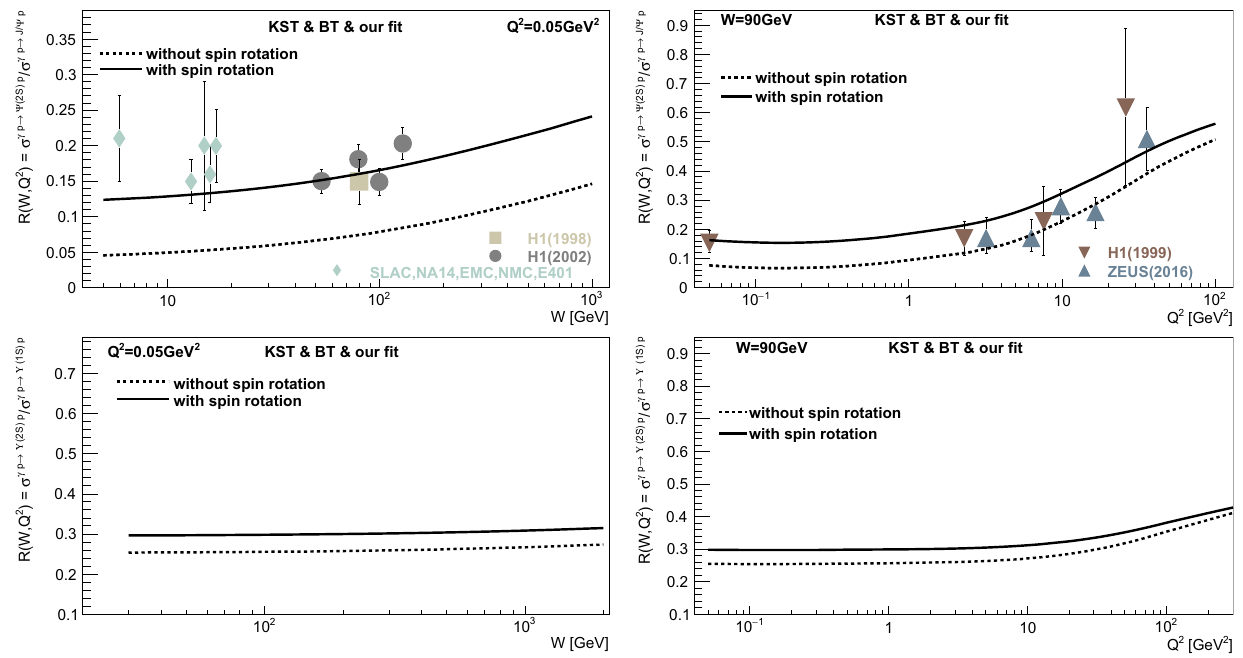
orations. The results, including also the Melosh spin rotation effects, were obtained using the phenomenological KST dipole cross section [15] and five different c − ¯ c and b − ¯ b interaction potentials described in Appendix